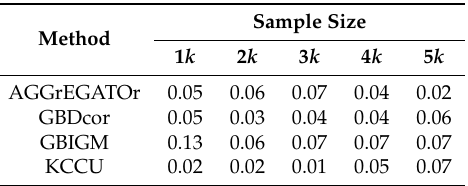
Table 4. Type-I error of the four methods in different sample sizes. AGGrEGATOr, a gene-based gene gene interaction; GBDcor, gene-based gene-gene interaction via distance correlation coefficient GBIGM, gene-based information gain method; KCCU, kernelized